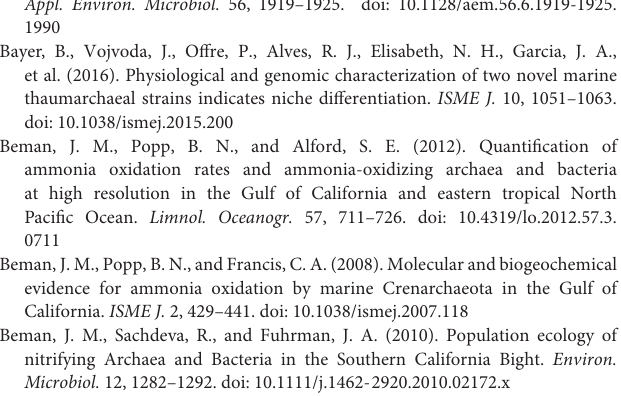
Supplementary Figure 1 | Annual cumulative alongshore (south–north) wind-stress starting from August. Different line colors indicate different annual wind cycles. Supplementary Figure 2 | Spatiotemporal variability of temperature, salinity, and density at the time series station (Sta.18). Supplementary Figure 3 | Spatiotemporal variability of cell abundances (1 × 10 4 cells mL − 1 ) for MG-II Euryarchaea ( A , upper panel) and GI.1a Thaumarchaea ( B , bottom panel) at the time series station (Sta.18). Black dots indicate the sampling dates. Supplementary Figure 4 | Ratio of AOA amoA copy-to-GI.1a Thaumarchaea cell ratios variability associated with surface, intermediate and bottom water layers at the different periods studied. Supplementary Figure 5 | Counts of bAOB amoA compared with AOA amoA gene copies (A) and with AOA amoA copy-to-GI.1a Thaumarchaea cell ratios. Data from surface (S), intermediate (I), and bottom water layers (B) are tagged. Supplementary Figure 6 | Comparison of average monthly inventories estimated for upwelling periods studied at different depth layers ML (mixed layer), OX (oxycline), BOT (Bottom). (A) Nitrous oxide (Farías et al., 2015; ML, mixed layer; SSL, subsurface layer) versus AOA, (B) Nitrate and bAOB, and (C) ammonium and non-photosynthetic picoplankton